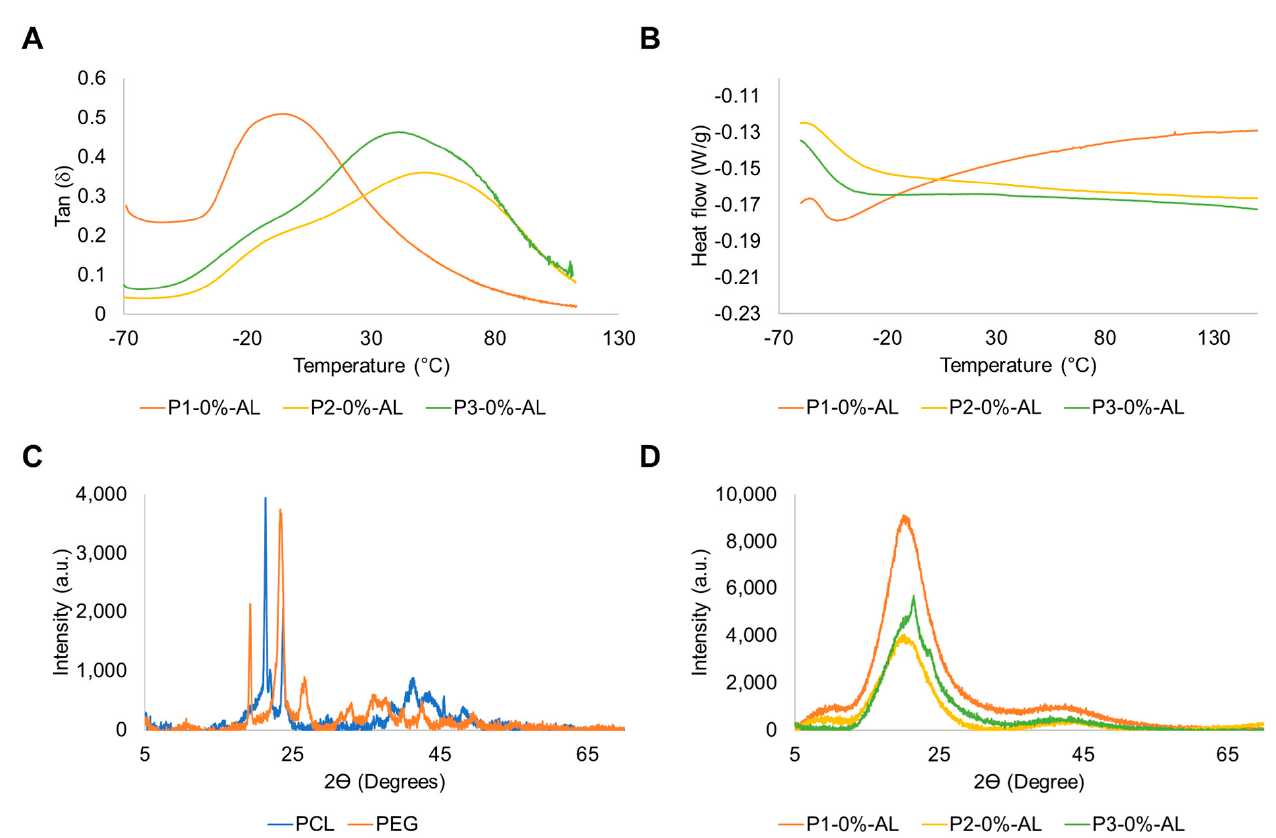
Figure 6. ( A ) Loss factor, ( B ) DSC, and XRD spectra of ( C ) polyols and ( D ) polymeric matrices without fillers.